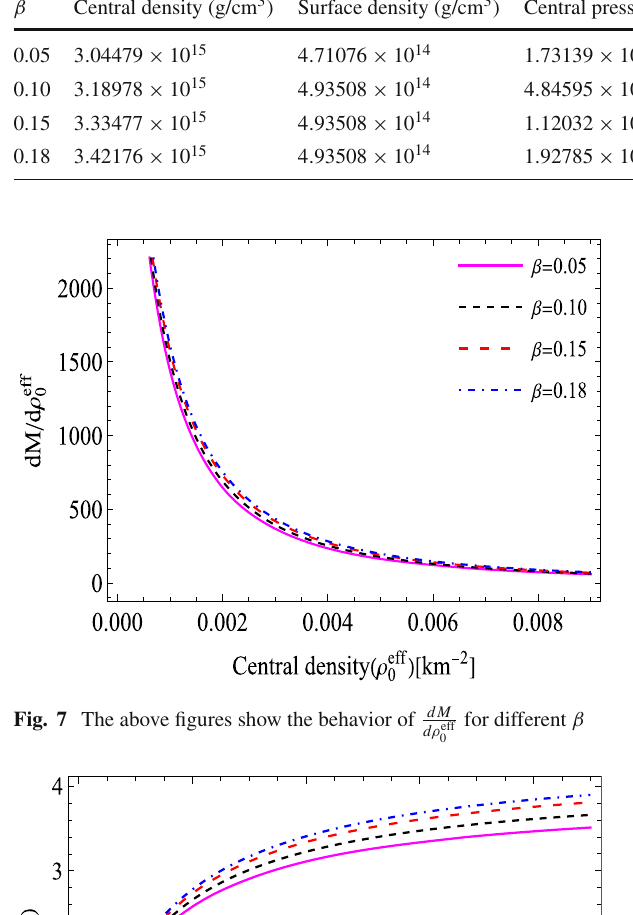
under radial oscillations, as can be seen from the M − ρ( 0 ) plot in Fig. 8.